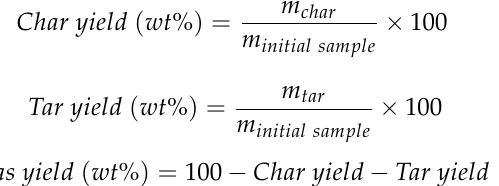
Figure 1. Fixed-bed reactor setup for the pyrolysis process.